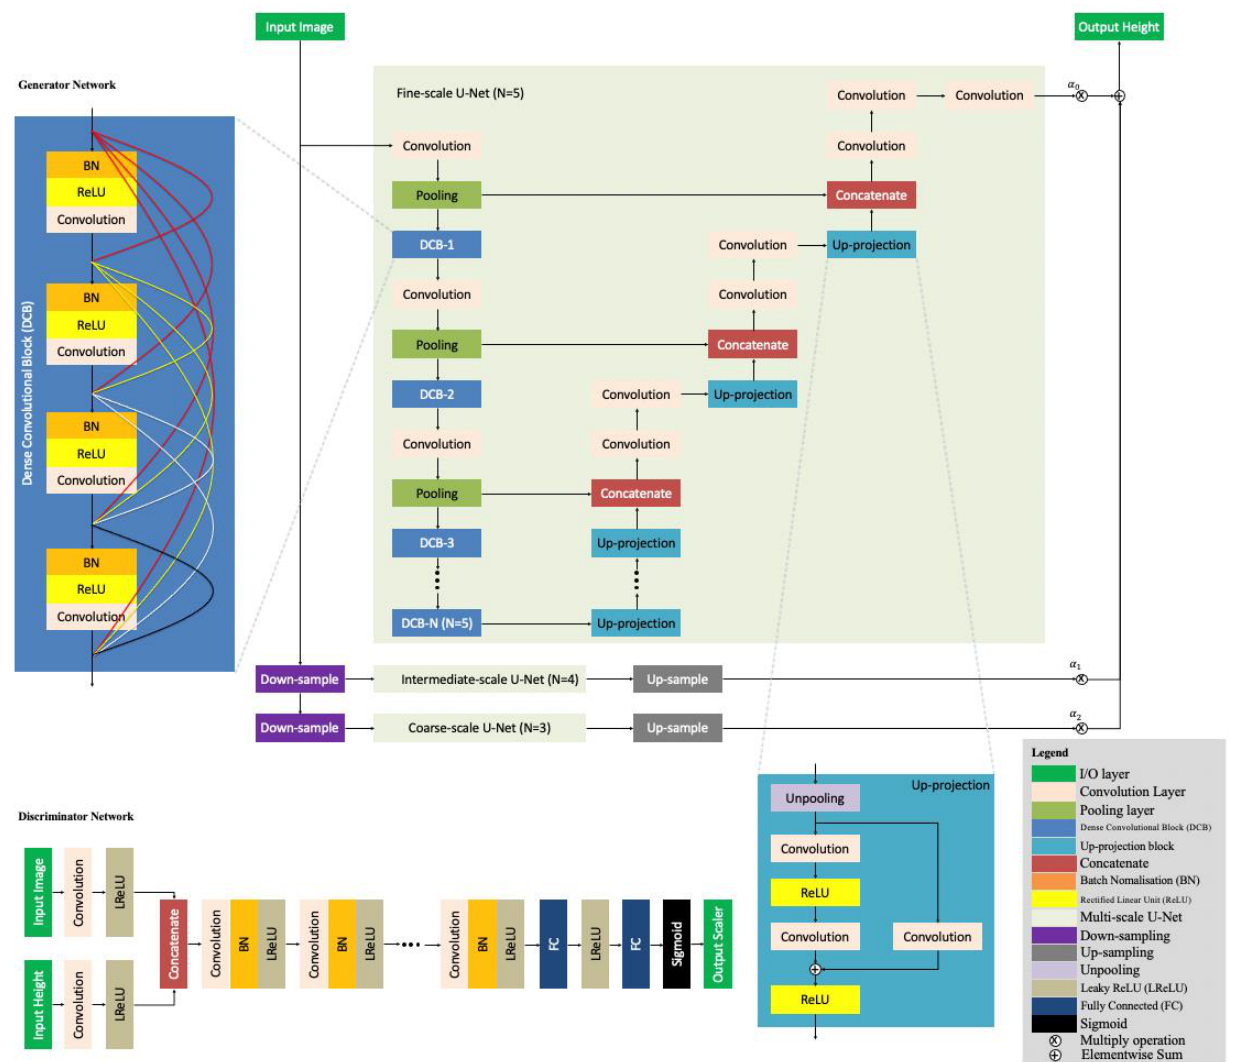
Figure 2. Network architecture of the proposed MADNet.